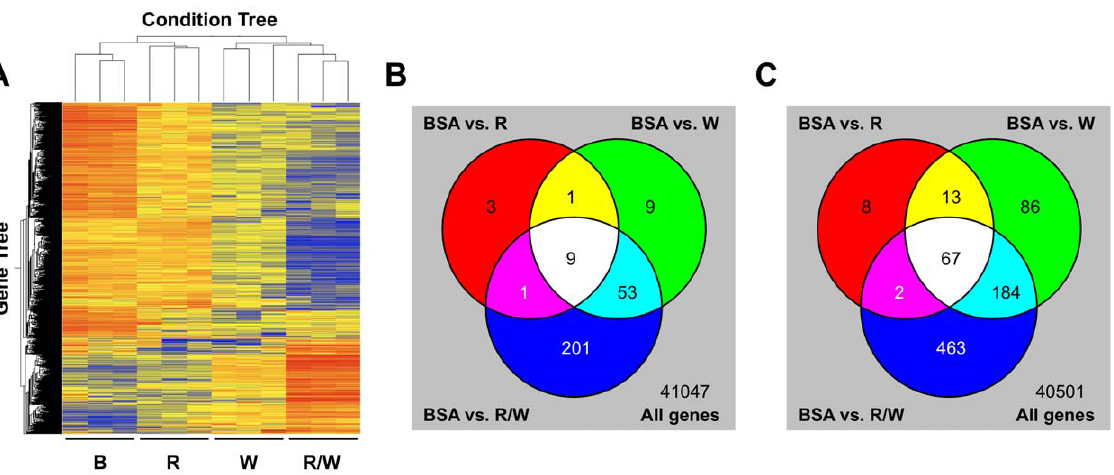
Figure 1. Schematic summary of Rspo2/Wnt3a-dependent gene expression in C57MG cells. ( A ) Heat map shows genes that were up- regulated (red) or down-regulated (blue) at least two-fold relative to the normal value (yellow). Microarray analysis was performed with RNA harvested and processed individually from three monolayers for each treatment group [B=BSA (16 ug/ml); R=Rspo2 (100 ng/ml); W=Wnt3a (100 ng/ml); R/W=Rspo2 (100 ng/ml) + Wnt3a (100 ng/ml)]. ( B ) Venn diagram indicates the number of genes that were up-regulated uniquely or in common by Rspo2, Wnt3a or the combination of both. ( C ) Venn diagram indicates the number of genes that were down-regulated uniquely or in common by Rspo2, Wnt3a or the combination of both.